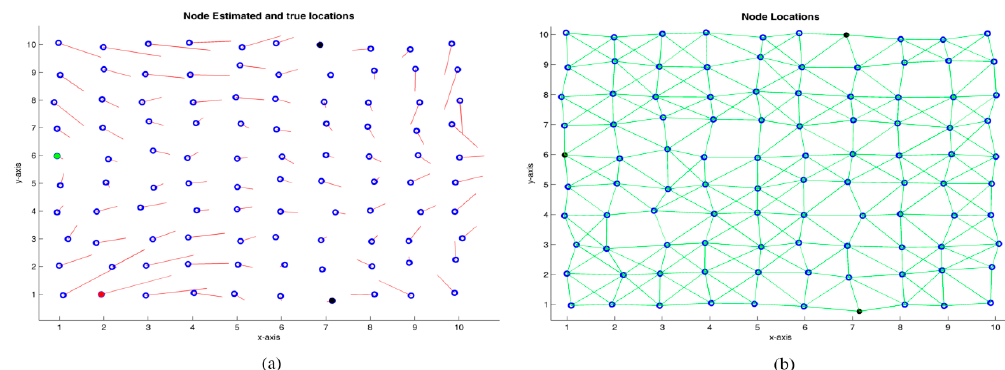
Figure 5. ( a ) Real node positions ( ) and error with respect to the estimated positions ( ), 𝑅 = 1.5𝑟 . ( b ) Real positions of the nodes and graph associated with the WSN.